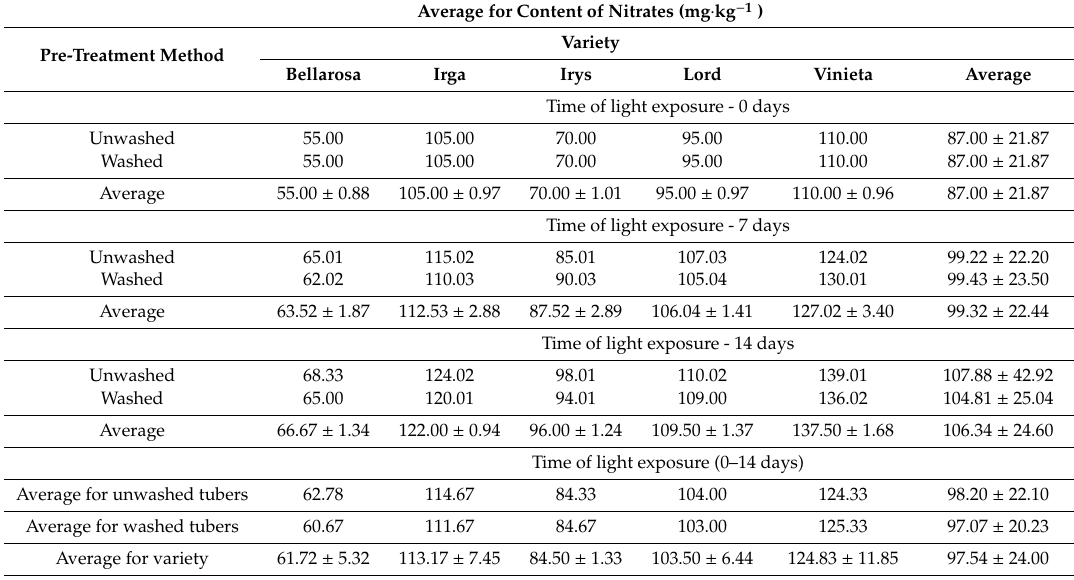
Table 2. Content of nitrates depending on the variety, pre-treatment method and time of exposure to light (mg · kg − 1 in fresch